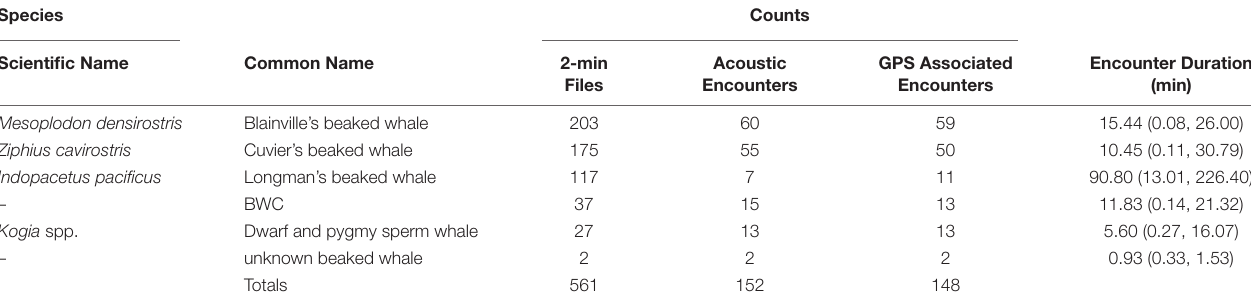
TABLE 3 | Acoustic detections of beaked whales and Kogia